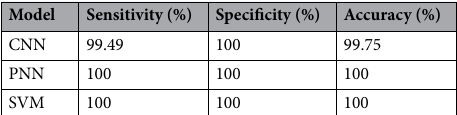
Table 2. Model indicators.